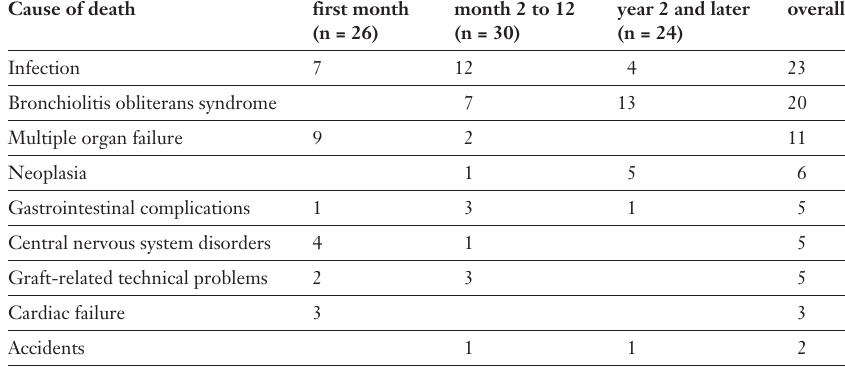
Kaplan-Meyer esti- mates of overall sur- vival after lung trans- plantation in Switzer- land compared to the data of the Registry of the International Society for Heart and Lung Transplantation (ISHLT). The patients transplanted in Switzerland since 1998 had a signifi- cantly improved prognosis (hazard ratio 0.44; p = 0.002).